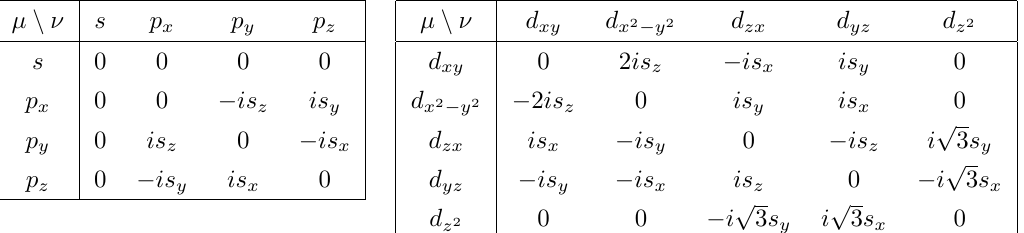
Table 2 . Summary of the matrix elements quantum numbers of µ and ν are the same. The left (right) panel shows the results for s and p ( d ) orbitals. Note that the spin operators are related to the Pauli matrices as s